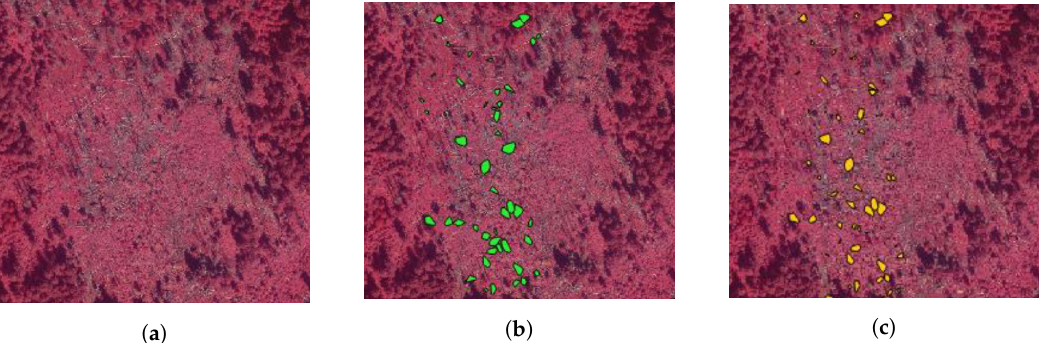
Figure 7. Verification of the snag classifier in Bavarian Forest National Park. ( a ) Small forest scene with living trees, dead trees and snags. ( b ) Labelled snags for verification (green). ( c ) Classified snags (orange) with threshold p snag > 90%. Table 14. Classification results of dead trees. Labelled data are from areas A 1, A 2, and A 3. Bavarian Forest National Park: 124 dead trees, 186 living trees for training. 310 dead trees, 761 living trees for testing. Confusion matrices for training (left): Number of living trees are reduced to the number of dead trees. Numbers refer to the average of the five test sets of the five-fold cross-validation.